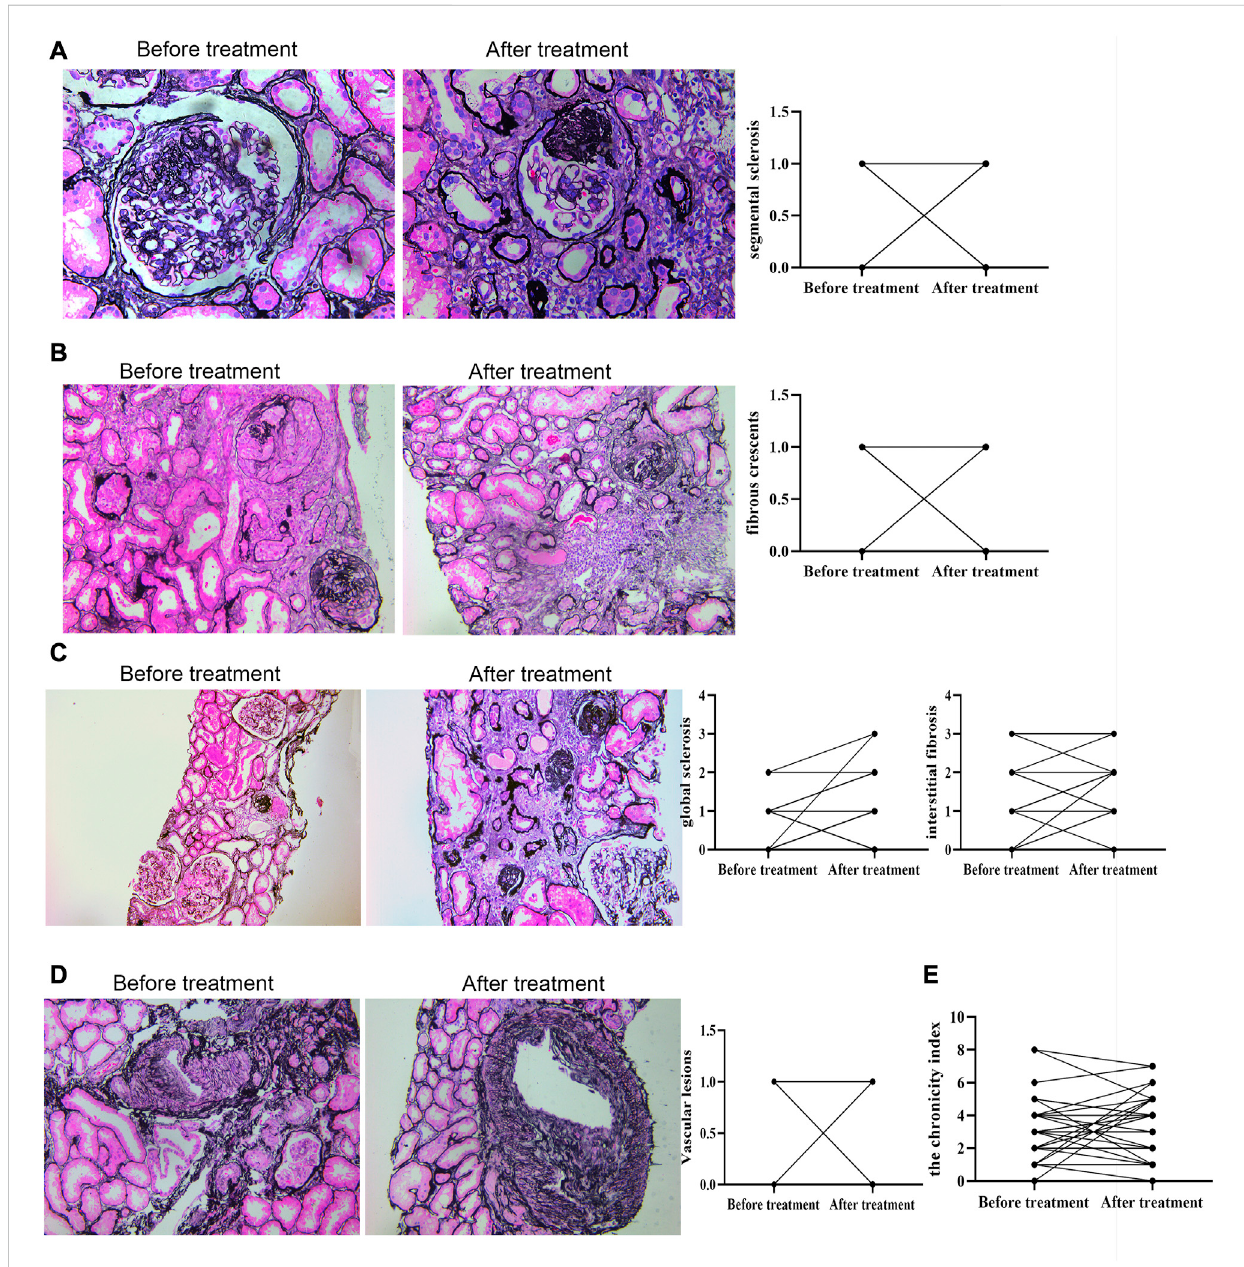
FIGURE 4 Chronic renal pathological changes before and after treatment by PAS staining. C: scale bar: 100 μ m; other fi gures: scale bar: 50 μ m. Chronic indexes of renal lesions were evaluated by Andreoli scoring method.